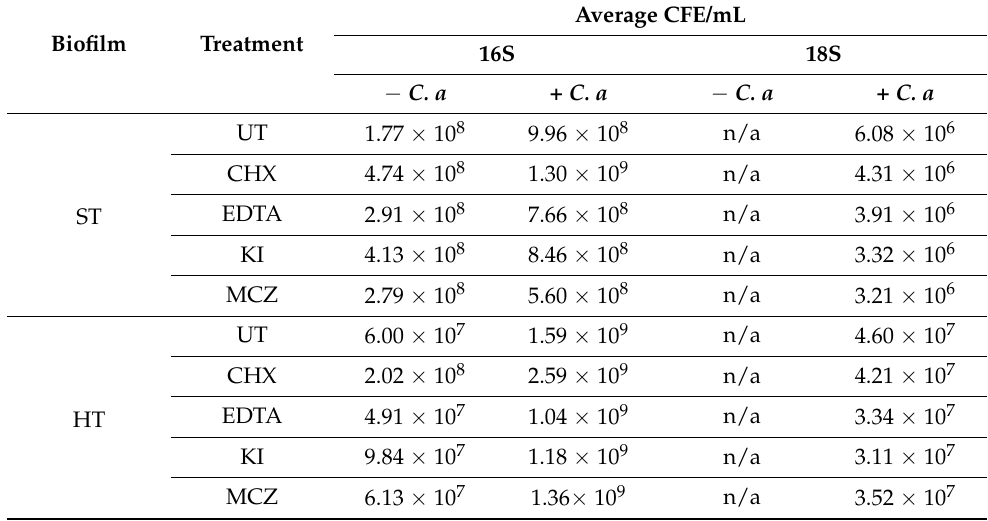
Table 3. Average colony forming equivalent counts for total bacteria and fungi in the two biofilm models following treatment. The mean CFE/mL for each biofilm was calculated from an average of 9 independent biofilms (n = 3 from 3 separate experiments) following treatment with CHX, EDTA, KI and MCZ compared to untreated